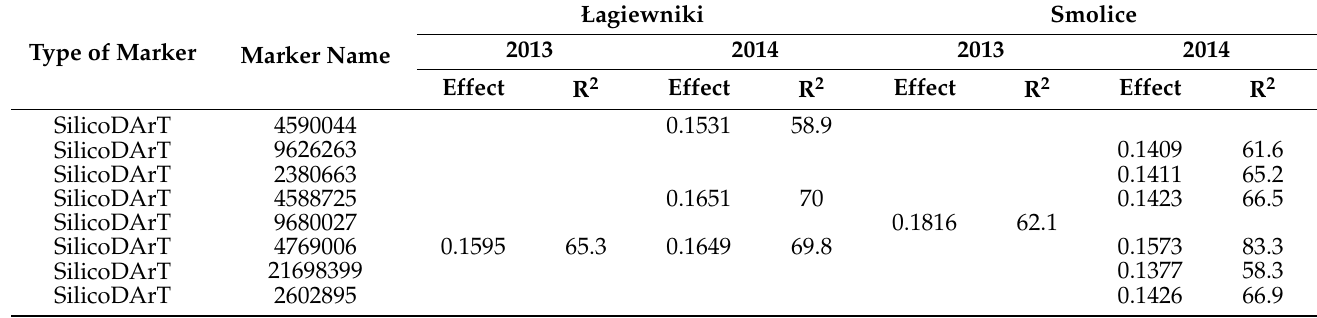
Table 4. Molecular markers associated with the heterosis effect of core diameter